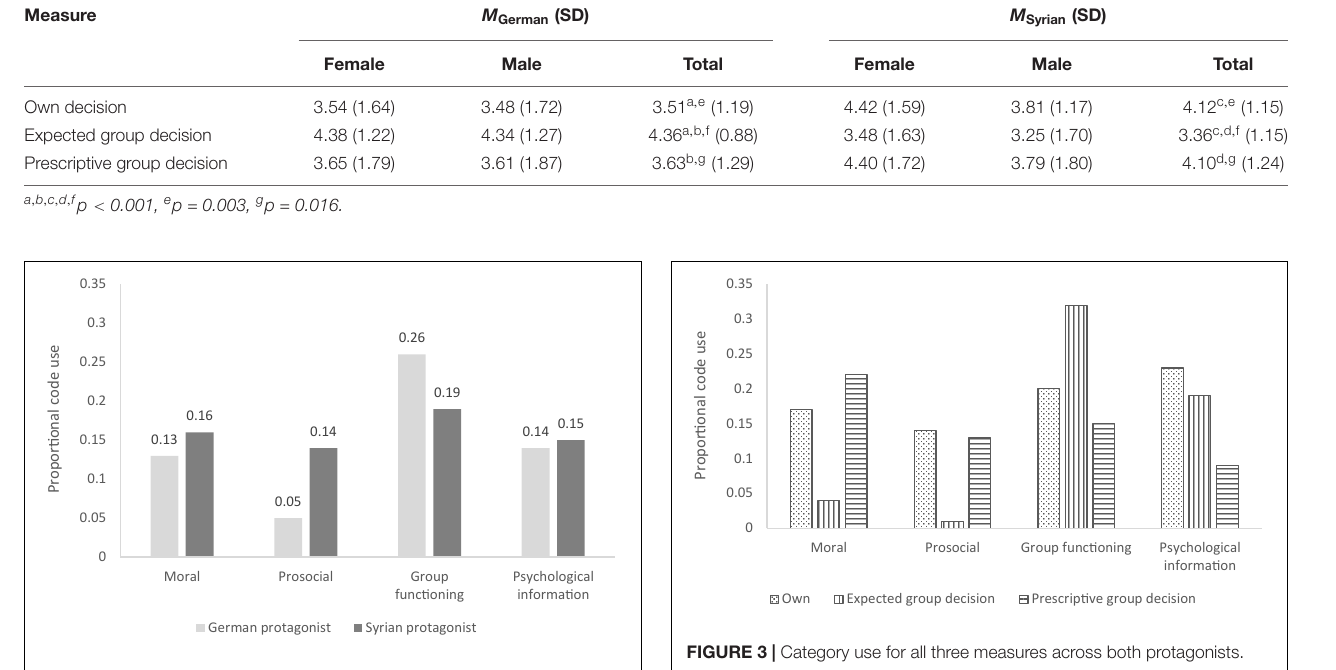
FIGURE 2 | Category use for both protagonists across all three measures.